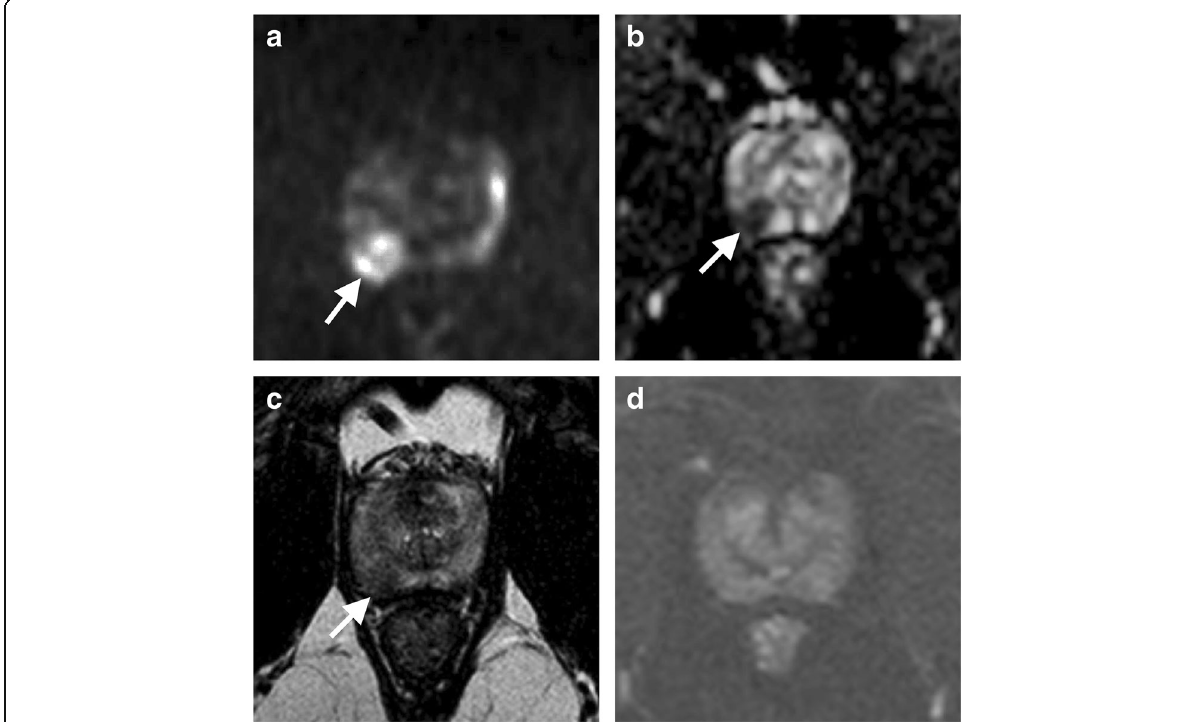
Fig. 3 Example case of mpMRI in which the information given by dynamic contrast-enhanced (DCE) imaging was redundant. A 54-year-old man with slightly elevated PSA level (3.43 ng/mL) and suspicious digital rectal examination underwent the examination to target biopsy, showing right midglandular < 15 mm in size PZ finding categorised as PI-RADS 4 because of focal restricted diffusion well visible as hyperintensity on the high b value image ( a ) and hypointensity on the ADC map ( b ), associated to hypointensity on a transverse T2-weighted image (arrows in c ). Cancer was proven by biopsy and then by pathology after surgery with Gleason score 7 (4 + 3). Of note, transverse subtracted DCE ( d ) had no role in detecting and localising cancer, showing no differences in contrast enhancement compared to the surrounding